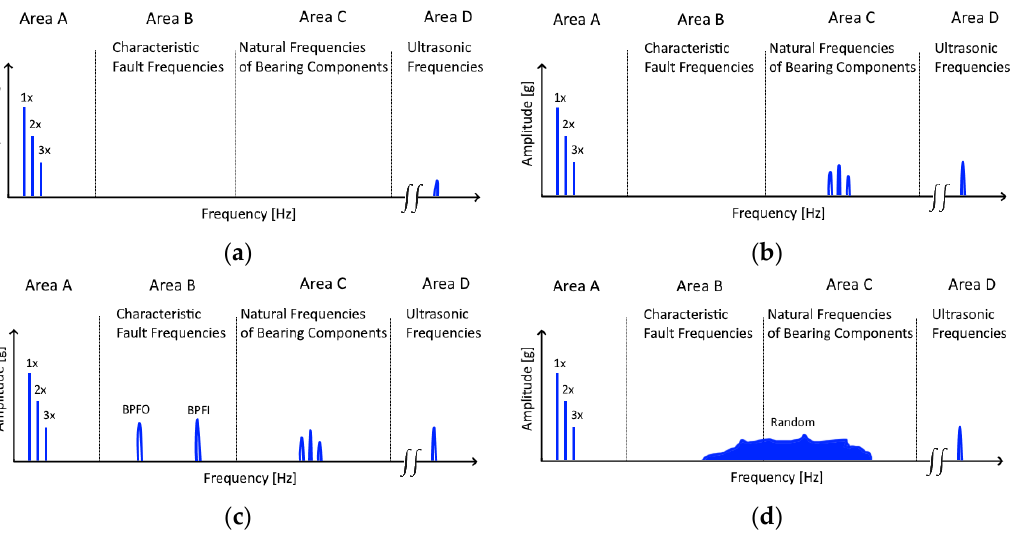
Figure 11. The four bearing degradation stages: ( a ) stage 1, contains the rotation frequencies and ultrasonic frequencies; ( b ) stage 2, the natural frequencies of the bearing become visible; ( c ) stage 3, the characteristic fault frequencies appear; ( d ) stage 4, the frequencies in area B and area C are replaced with random noise.